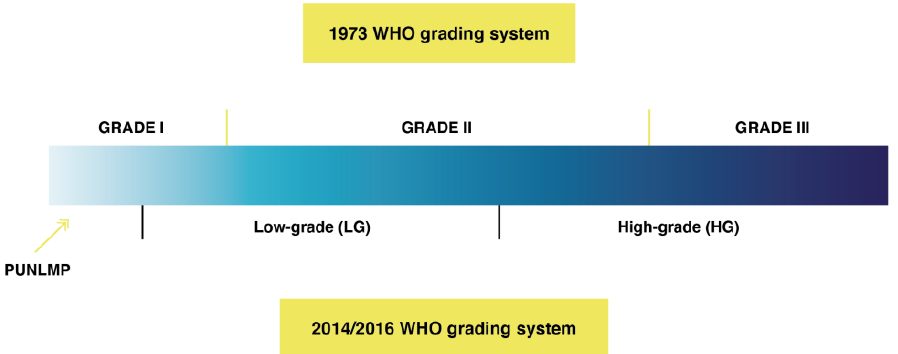
Figure 3. WHO grading systems for non-muscle-invasive bladder cancer. (PUNLMP: papillary urothelial neoplasms of low malignant potential).